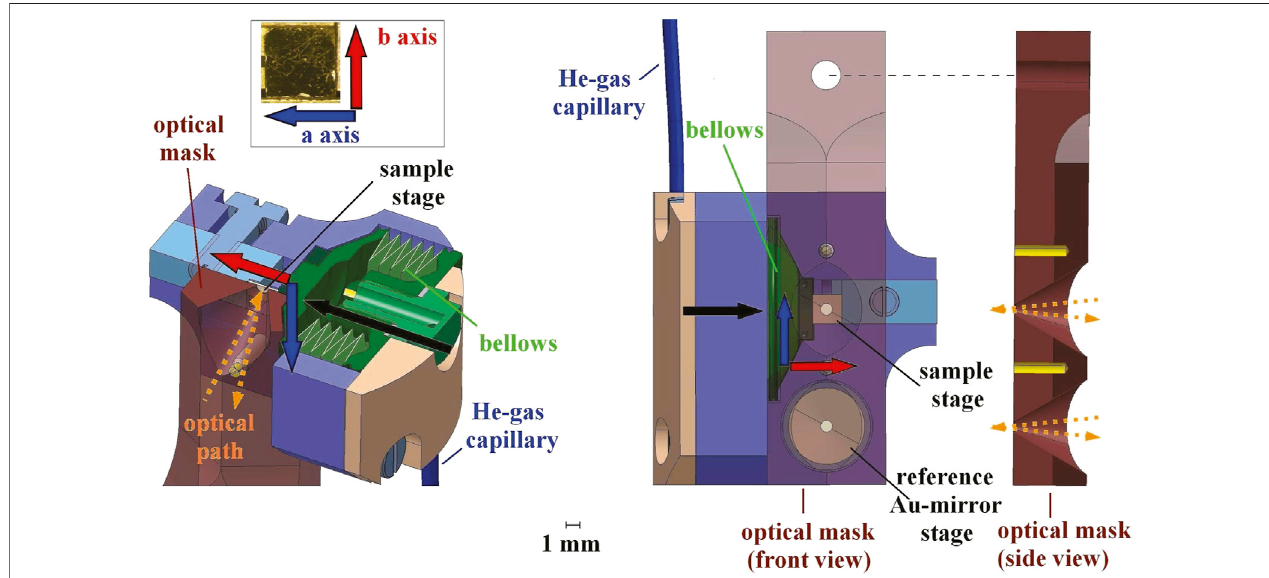
FIGURE 1 | (color online) (left) Three-dimensional schematic view of the stress device with a cross-section along the plane of the incident/re fl ected optical path. (right) Front view along the light path. By fl ushing He-gas into the spring bellows and evacuating its volume, one can exert and release stress, respectively, along the directioncorrespondingtothe(shorter)orthorhombic b -axis,asindicatedbytheblackarrow.Theopticalmask,placedontopofthestressdevice,de fi nesequalspotsof the sample and reference Au-mirror surface, which are exposed to the electromagnetic radiation polarized along the a - and b -axis (blue and red arrow, respectively). Reproduced from Ref.